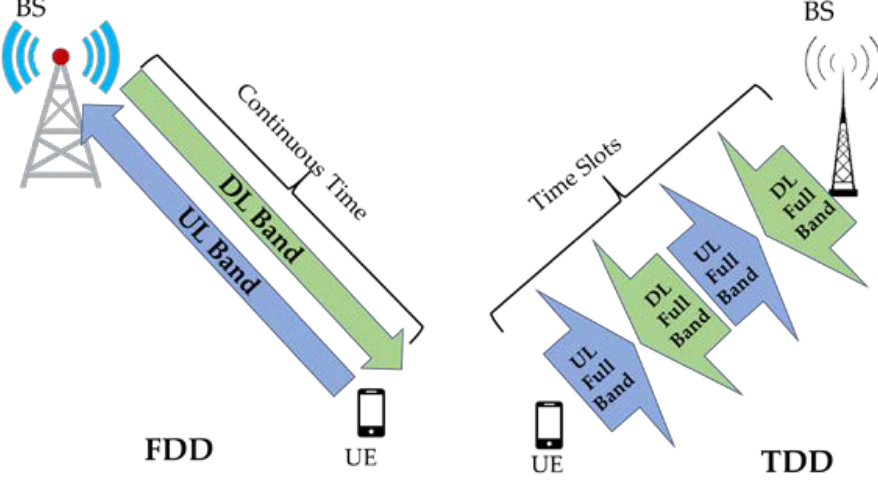
Figure 4. The FDD and TDD modes.